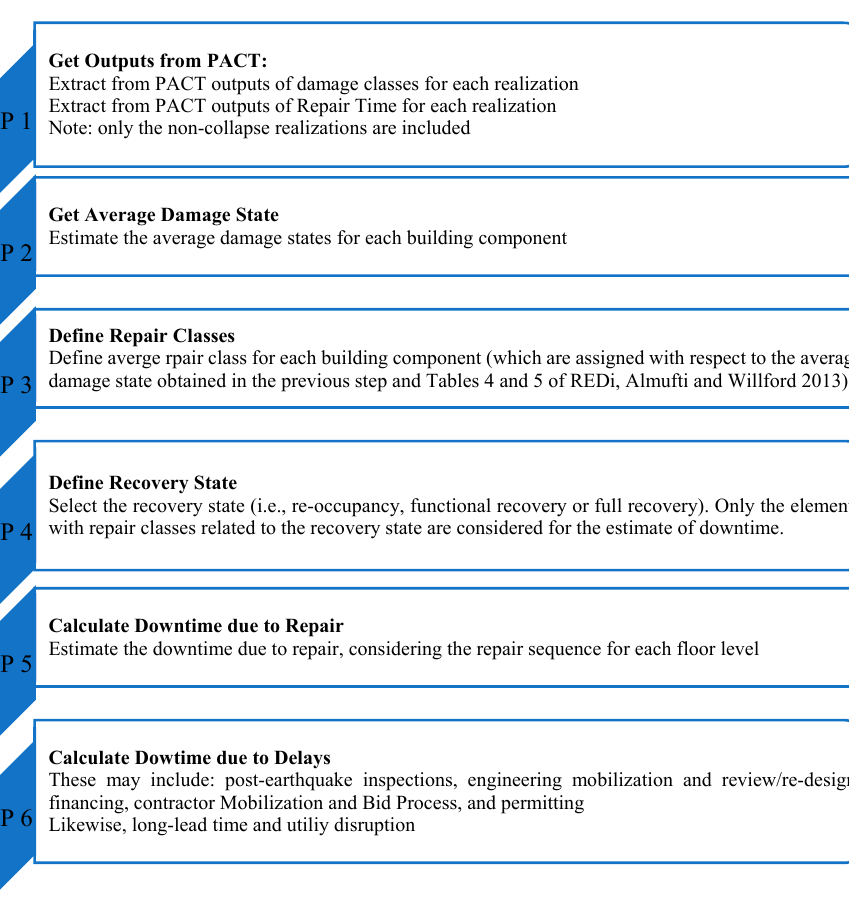
Figure 4. Steps to estimate recovery time through REDi guidelines, Almufti and Willford 2013 [1].